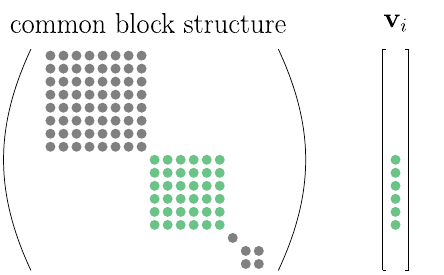
Fig. 6 Illustration of a localized eigenvector. The vector v i is localized within the green block of the matrix. The nonzero entries of the matrix and the vector are represented as